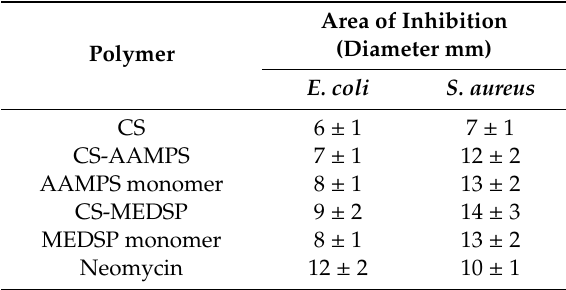
Table 1. Inhibition growth zones of CS and its derivatives against the studied strains, compared with the used monomers and